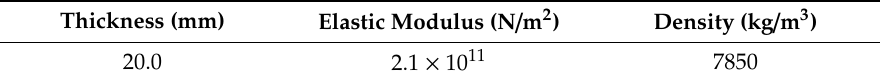
Table 1. The property of model.